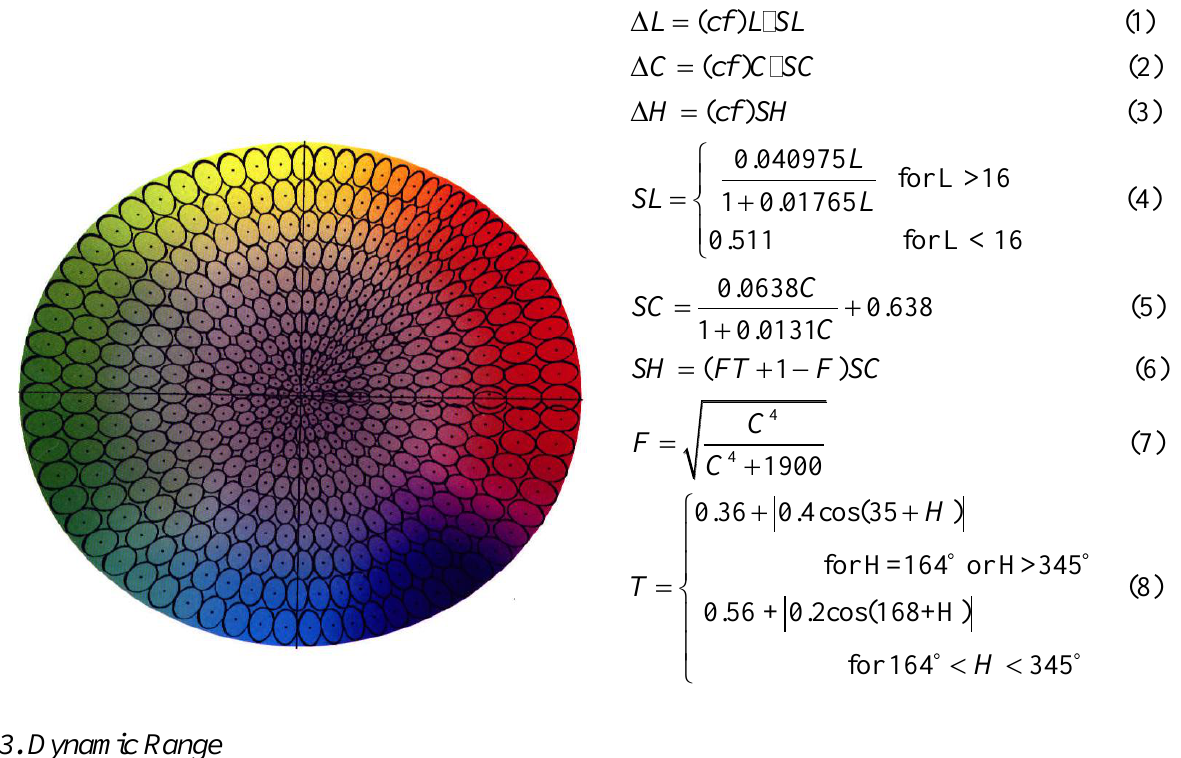
Figure 5. Color Measuring Committee Tolerance